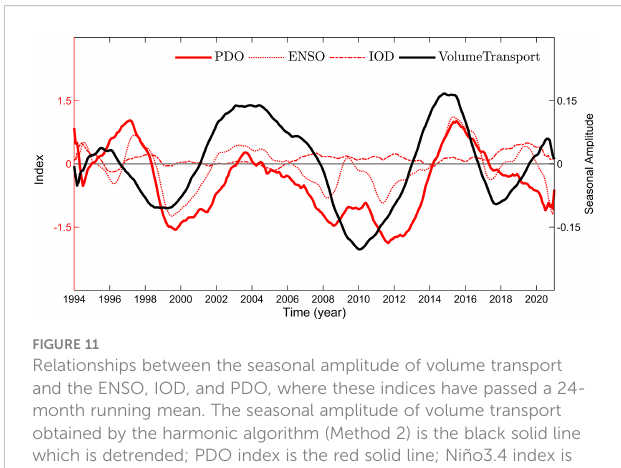
FIGURE 11 Relationships between the seasonal amplitude of volume transport and the ENSO, IOD, and PDO, where these indices have passed a 24- month running mean. The seasonal amplitude of volume transport obtained by the harmonic algorithm (Method 2) is the black solid line which is detrended; PDO index is the red solid line; Niño3.4 index is the red dashed line; DMI index is the red dot-dashed